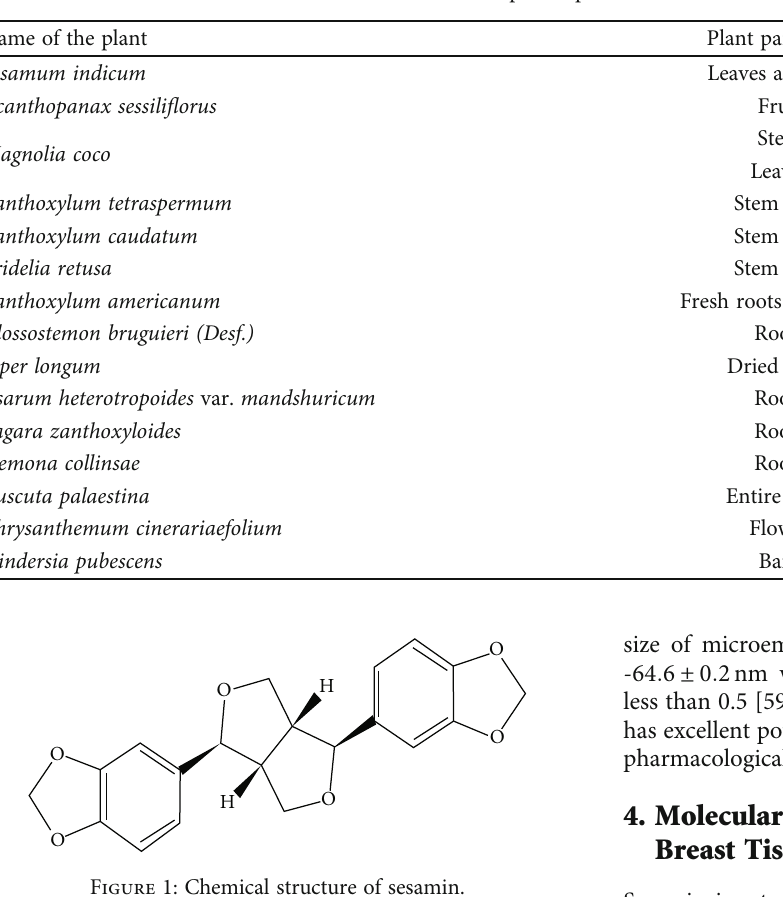
Table 1: Reported plant sources of sesamin.